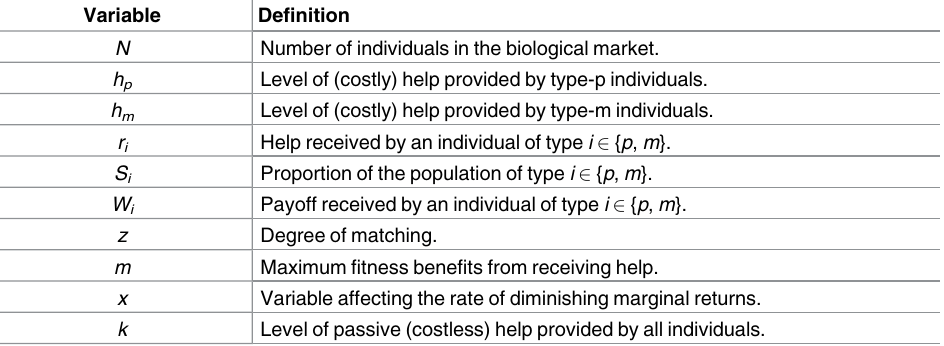
Table 1. List of variables used in the model.